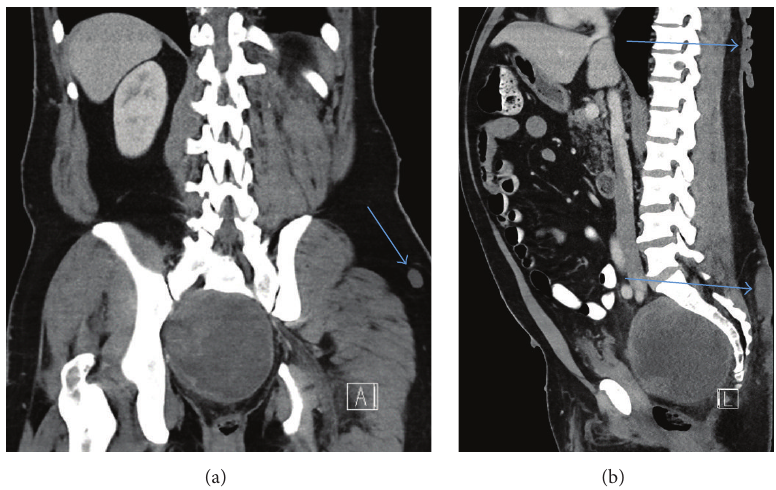
Figure 7: (a) Coronal CT shows heterogeneous pelvic mass and a left hip subcutaneous neurofibroma (arrow) which has the same attenuation as muscle. (b) Sagittal CT shows heterogeneous pelvic mass and numerous posterior subcutaneous neurofibromas (arrows) which have the same attenuation as